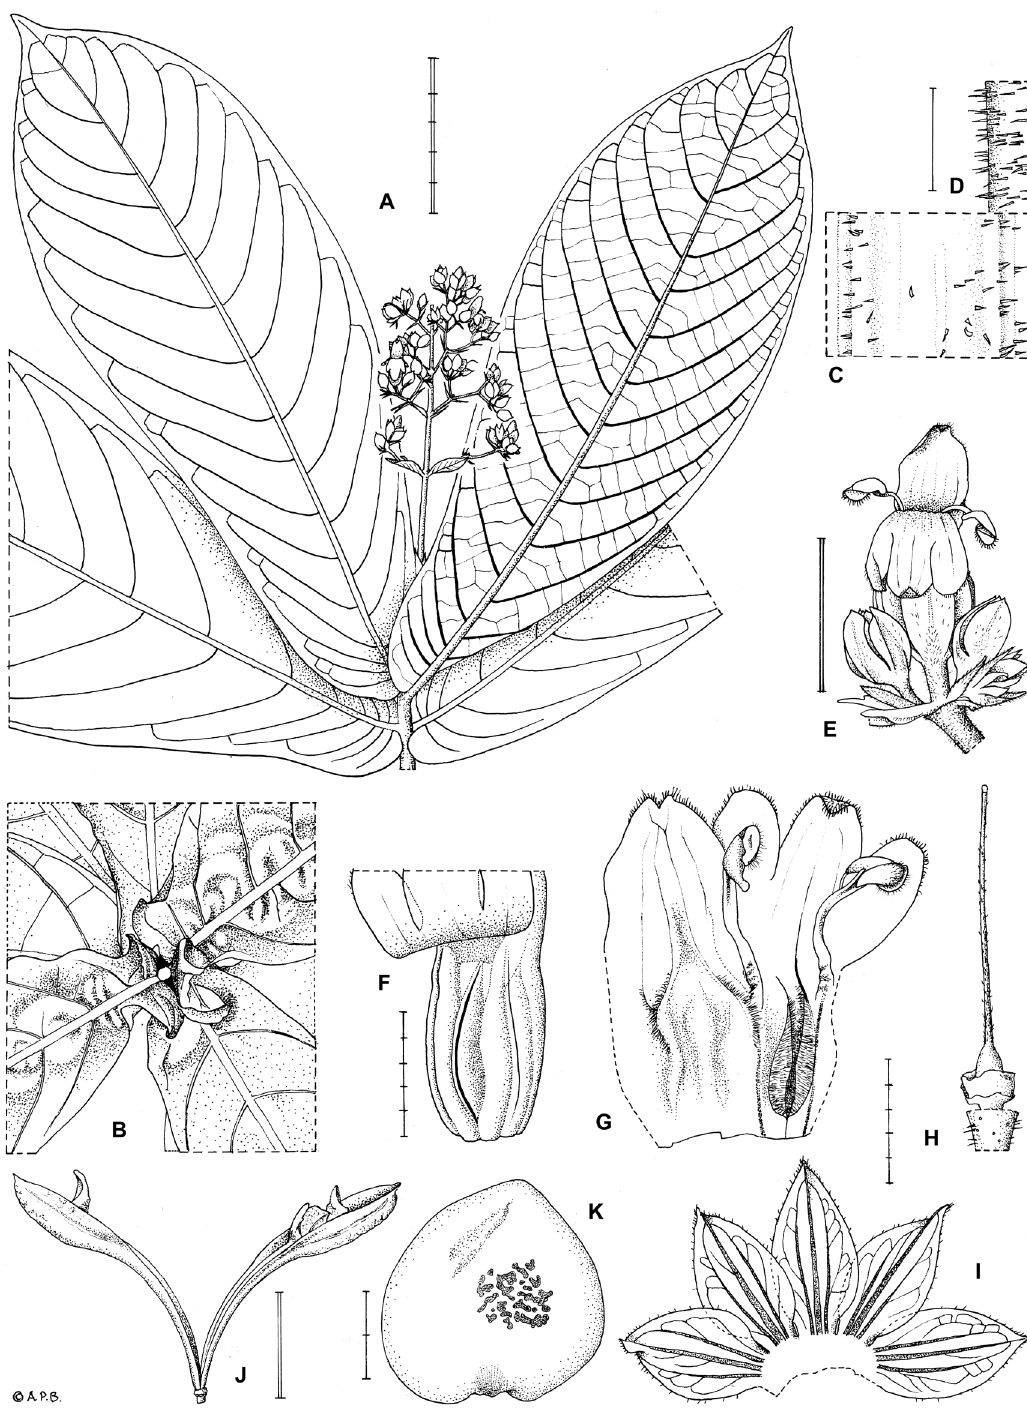
Figure 1 – Justicia gigantophylla . A . Upper part of plant with inflorescence (lacking terminal portion); artificially enlarged to avoid being obscured by right-side leaf. B . View of leaves (from photograph) in live plant from above to show puckering of young leaf surfaces and undulate leaf margins. C . Indumentum on axial midrib. D . Indumentum on pedicels/peduncles. E . Flower, face view, and neighbouring buds on lateral branch of inflorescence. F . Anterior face of corolla tube (with lobes raised) to show deep median and shallower lateral inflations. G . Corolla, cut and opened – the deep median inflation (on the right) is lined with inside as well as at its margins. H . Disc, ovary, style and stigma. I . Calyx, cut and opened, inner surface. J . Fruit, dehisced, with one immature seed in situ. K . Mature seed – pattern indicated is present over both surfaces. A, C–I from Cheek 17553 (K). B from field photograph by M. Cheek (see fig. 2). J and K from Letouzey 4095 (K). Scale bars: single bar = 1 mm; graduated single bar = 2 mm and 5 mm; double bar = 1 cm; graduated double bar = 5 cm. Drawn by Andrew